Question: Give a one-sentence summary of this figure.
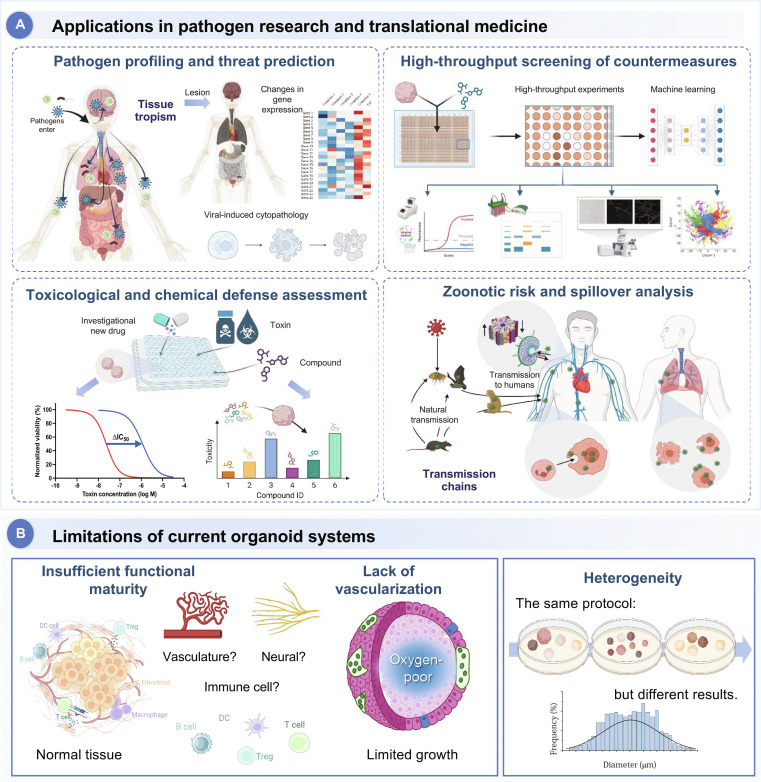
Answer: Integrated pathogen assessment pipeline and key limitations. (A) Application directions: pathogen profiling and threat prediction, high-throughput antiviral drug screening, toxicology and chemical defense assessment, and zoonotic disease and spillover risk analysis. These provide essential in vitro models for understanding pathogenesis, accelerating drug development, and enhancing public health preparedness. (B) Major limitations of current organoid platforms include insufficient functional maturity, the absence of resident immune components, diffusion-limited growth, and persistent batch-to-batch variability despite protocol standardization. Created with BioRender.com .